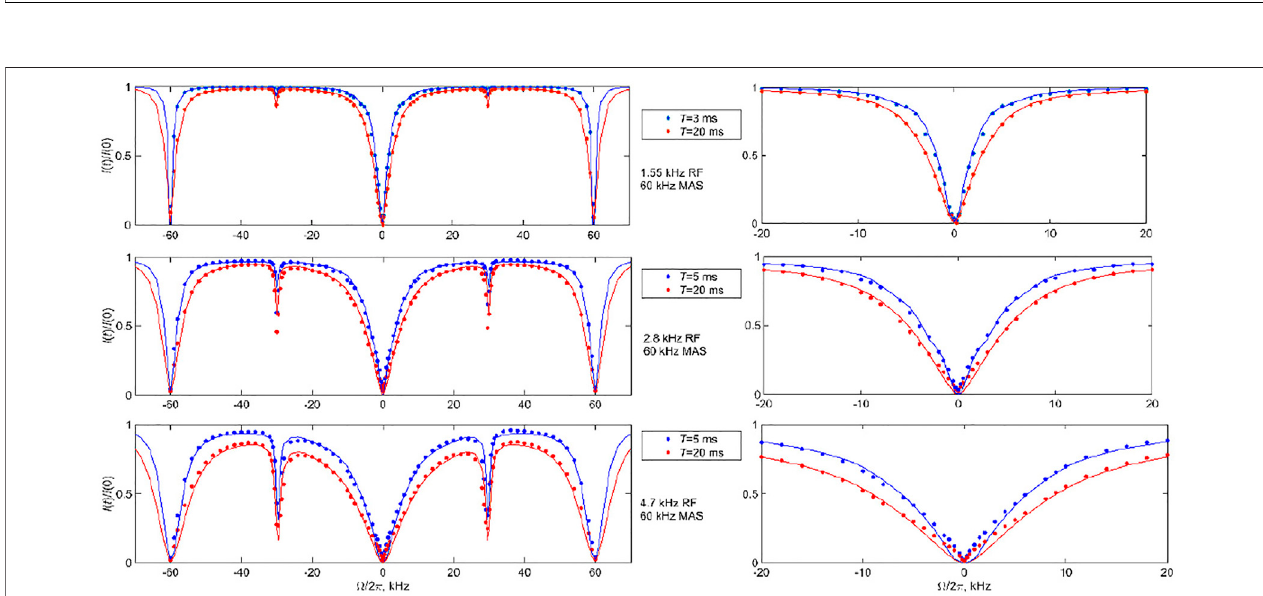
FIGURE 9 | 2 H CEST central band pro fi les for DMS at the 60 kHz MAS rate. Experimental normalized integrated central band intensities I ( t )/ I (0) versus resonance offsets Ω / 2 π forthesaturation fi eldsof1.55,2.8,and4.7 kHzandsaturationtimesindicatedonthepanelsat14.1Tand55 ° C.Therightpanelsshowtheexpansionofthe − 20 – +20 kHz offset region. The solid lines represent the best fi t to the data to the model of Figure 3A with a k fl 3.2 · 10 9 s − 1 . The effect of RF inhomogeneity with the inhomogeneity pro fi les of Figure 1B was included as described in the text.